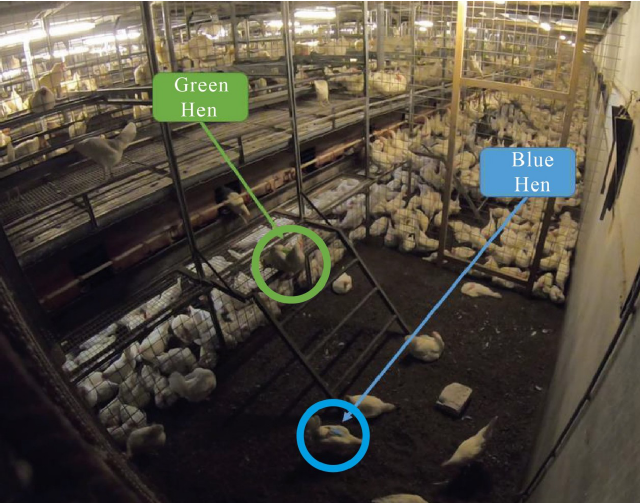
Figure 2. The experimental setup where two annotated hens are backpacked for data collection.